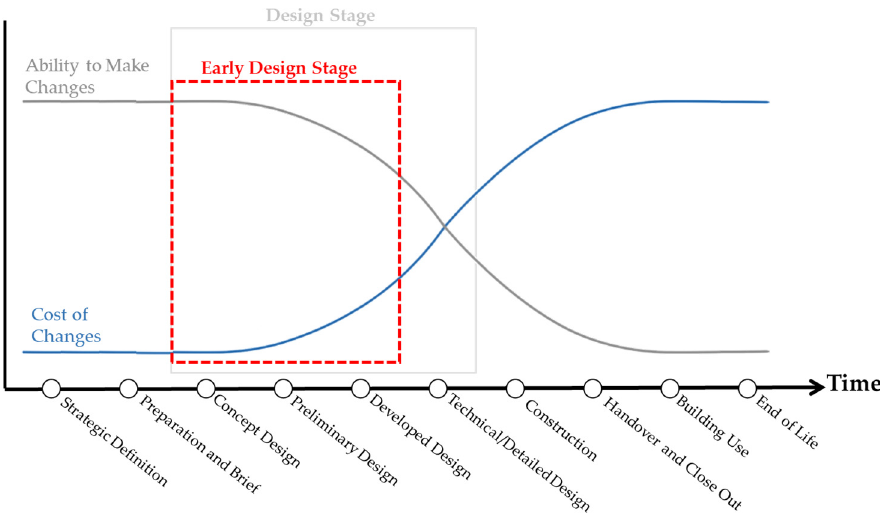
Figure 1. Cost versus design changes during a green building design process [22].